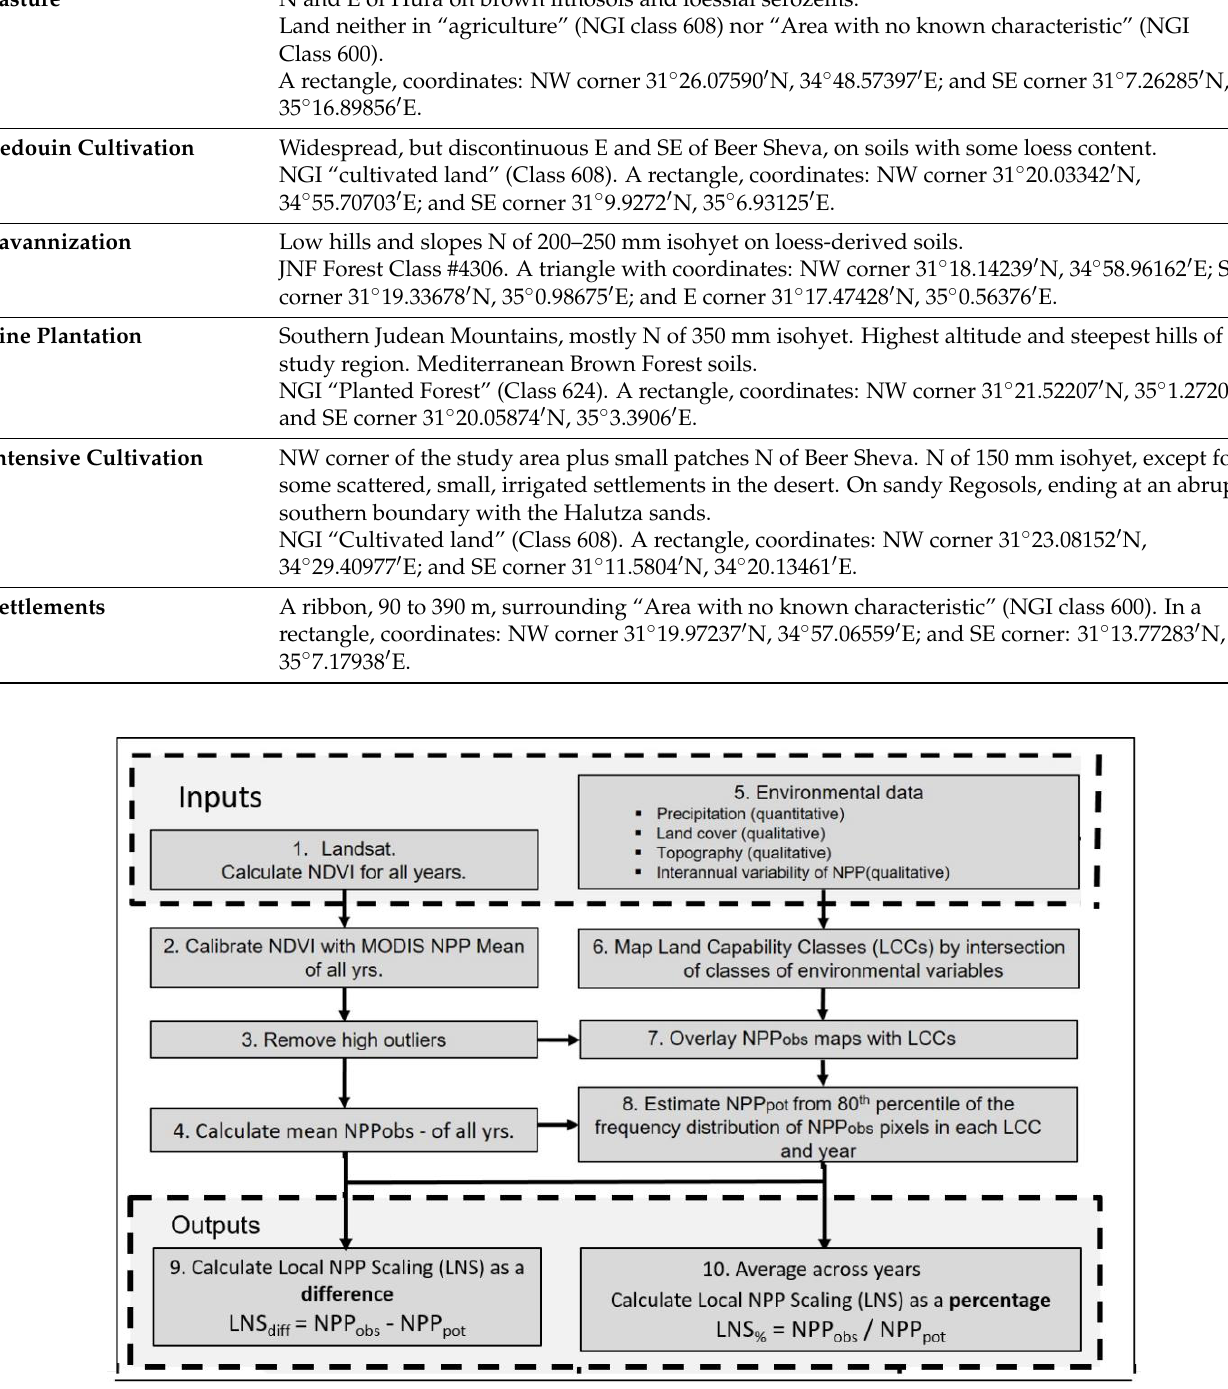
Table 1. The six land use types used in the study, and locations of detailed study sites (also shown in Figure 1). Land use from [23] and JNF (Jewish National Fund, Keren Kayemet LeYisrael) [personal communication], and soil types from [24]. Land Use (LU) Descriptions and Locations of Detailed Study Sites